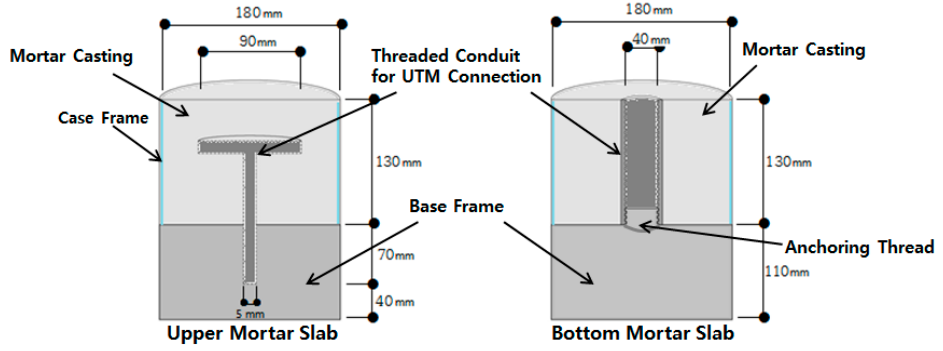
Figure 2. Mortar specimen casting in mold concept diagram.